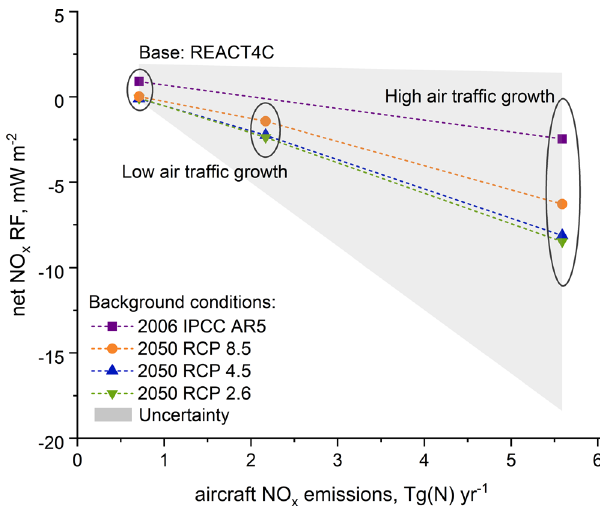
Fig. 4 Net NO x radiative forcing by emission rate, updated CH 4 parameterisation. Aviation net NO x radiative forcing (RF) (the sum of the short-term positive O 3 RF perturbation and the negative RF terms caused by a reduction in CH 4 lifetime, see Methods), by aviation NO x emission rate according to a range of background emission scenarios, utilising the updated simpli fi ed expression for the calculation of CH 4 forcing of Etminan et al. 23 Aviation net NO x RF systematically decreases with increasing NO x emissions from aviation, showing a variation according to the background surface emissions, with high mitigation (RCP 2.6) having a smaller aviation net NO x RF than, lower mitigation scenarios (RCP 4.5, RCP 8.5) for the same aviation NO x emission. The pattern of behaviour is in contrast to Fig. 1 because the updated CH 4 forcing expression accounts for the short-wave forcing of CH 4 , increasing CH 4 RF estimates by approximately 25%, which in the case of aviation net NO x impacts greatly increases the negative terms from the reduction in CH 4 lifetime from aviation NO x , tipping the net NO x term from being positive to negative with increasing aviation NO x emissions. Overall uncertainties are indicated by the grey shading, which is one standard deviation (68% con fi dence interval) from the ensemble of 20 NO x studies presented in Supplementary Fig.